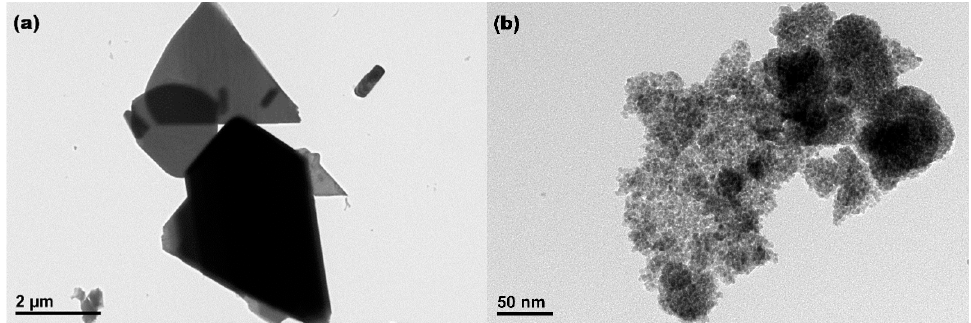
Figure 2. TEM images of ( a ) commercial Ce 2 (CO 3 ) 3 • x H 2 O particles and ( b ) CeO 2 sample synthesized hydrothermally at 200 °C for 24 h with 10 mL H 2 O 2 .